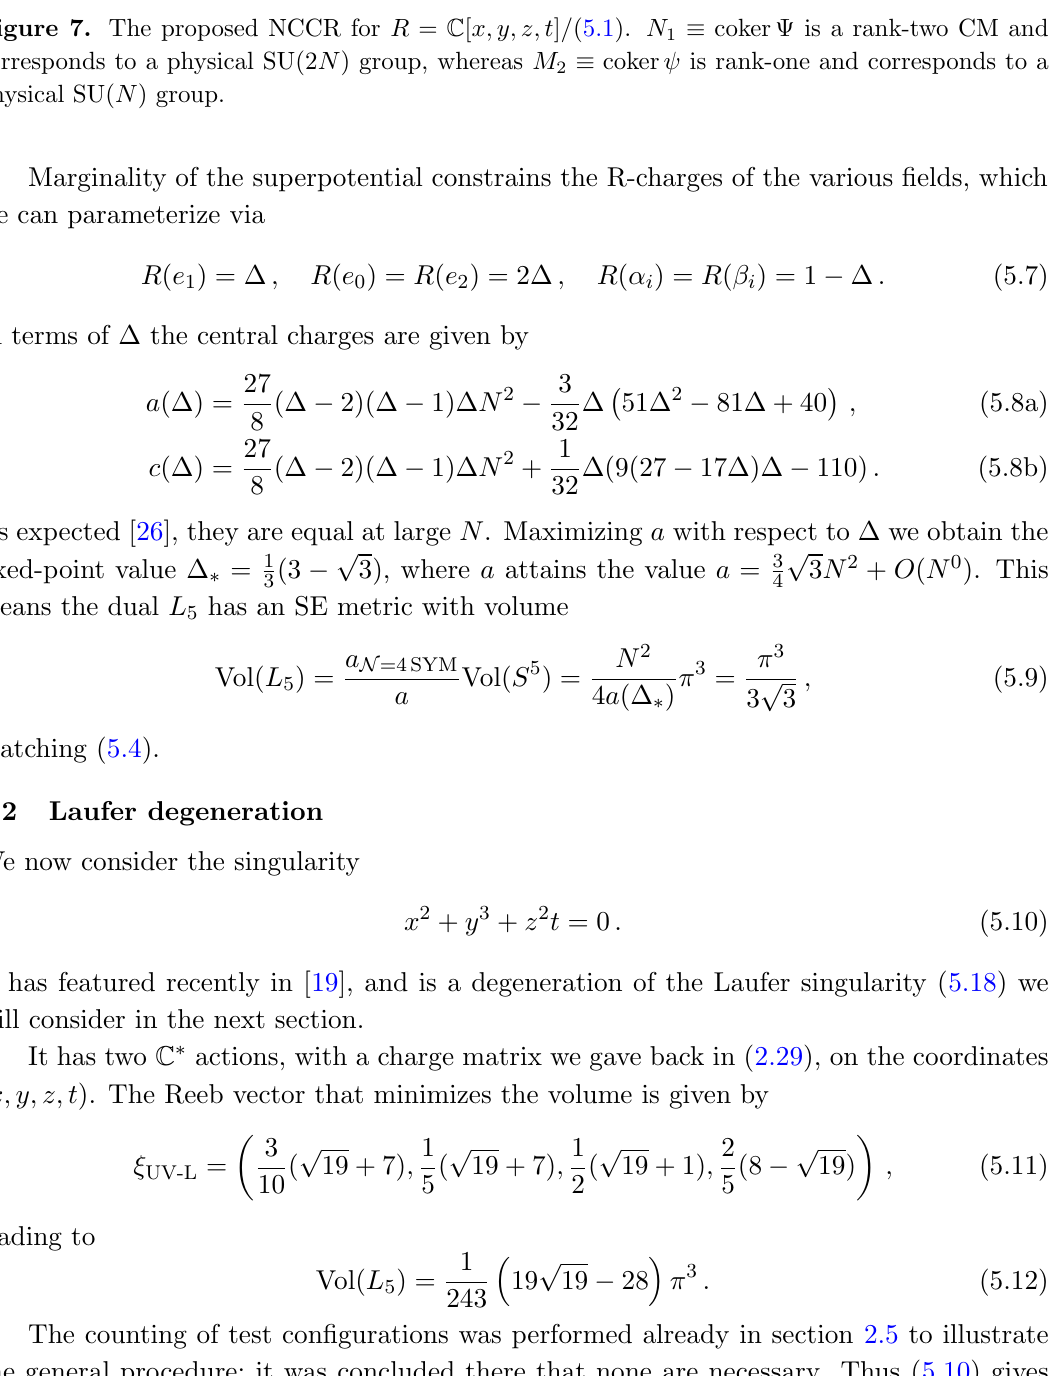
(cid:17) coker (cid:9) is a rank-two CM and 1